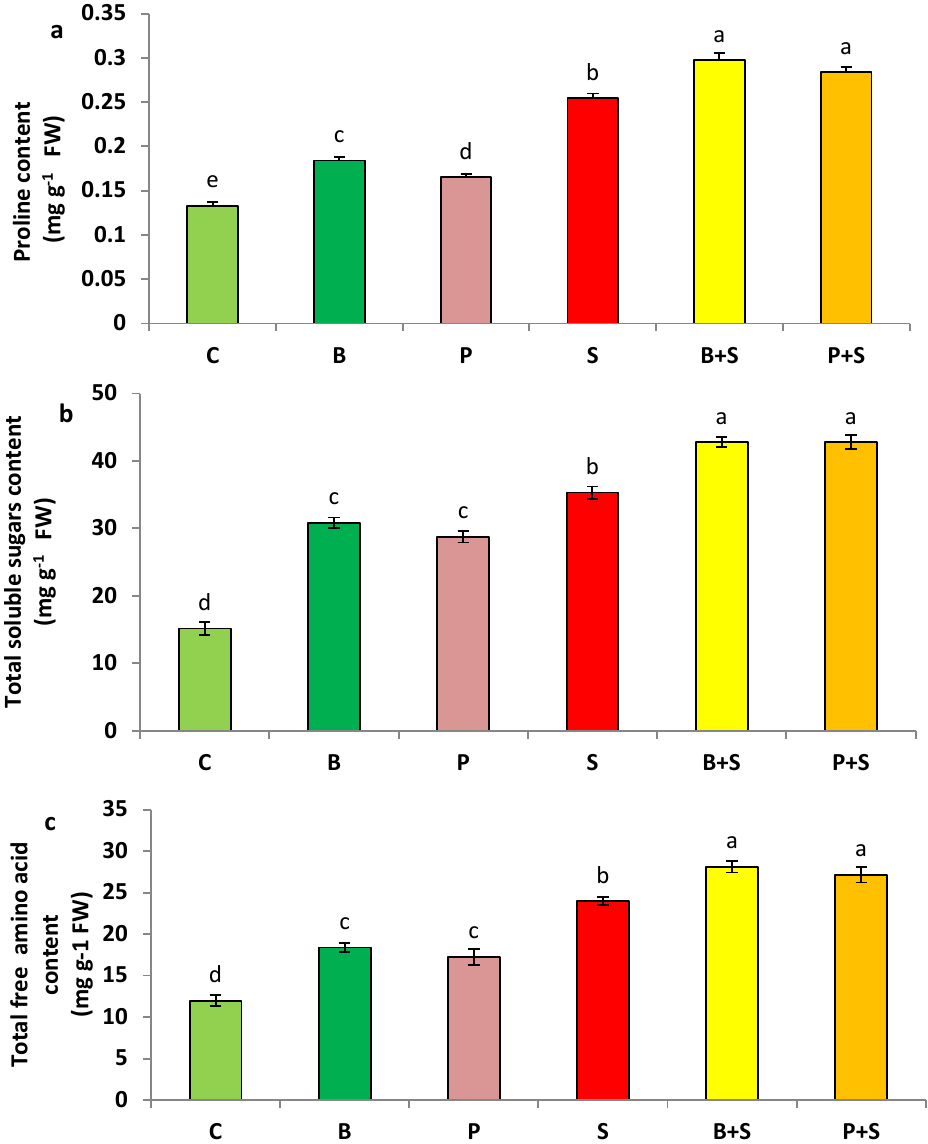
Figure 2. Effect of BABA and PEG seed priming on proline ( a ), total sugar content ( b ), and total amino acids ( c ) in cowpea seedlings exposed to PEG stress. C (control), B (BABA-primed seedlings without any stress), P (PEG-primed seedlings without any stress), S (unprimed seedlings subjected to PEG stress), B + S (BABA-primed seedlings subjected to PEG stress), P + S (PEG-primed seedlings subjected to PEG stress). Values represent the mean ± SE of three independent experiments. Alphabetical letters show significant difference between treatments performed using Duncan’s multiple range test.